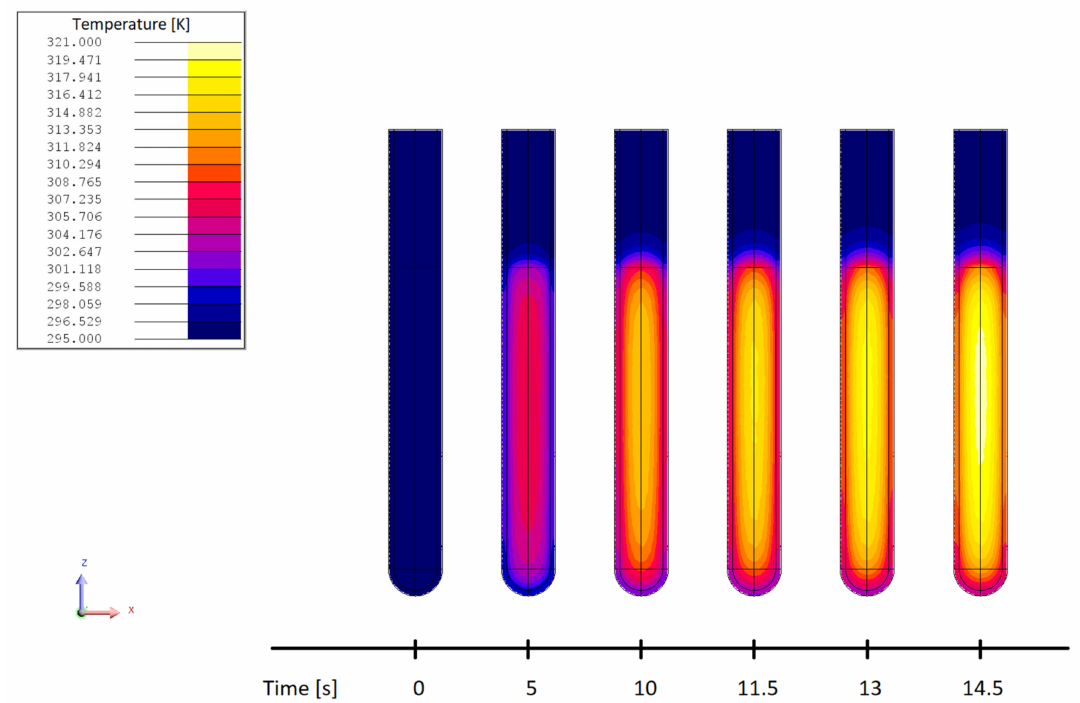
Figure 11. Cross-section view of the time dependence of temperature distribution inside the container, at f = 281 kHz and H = 7.83